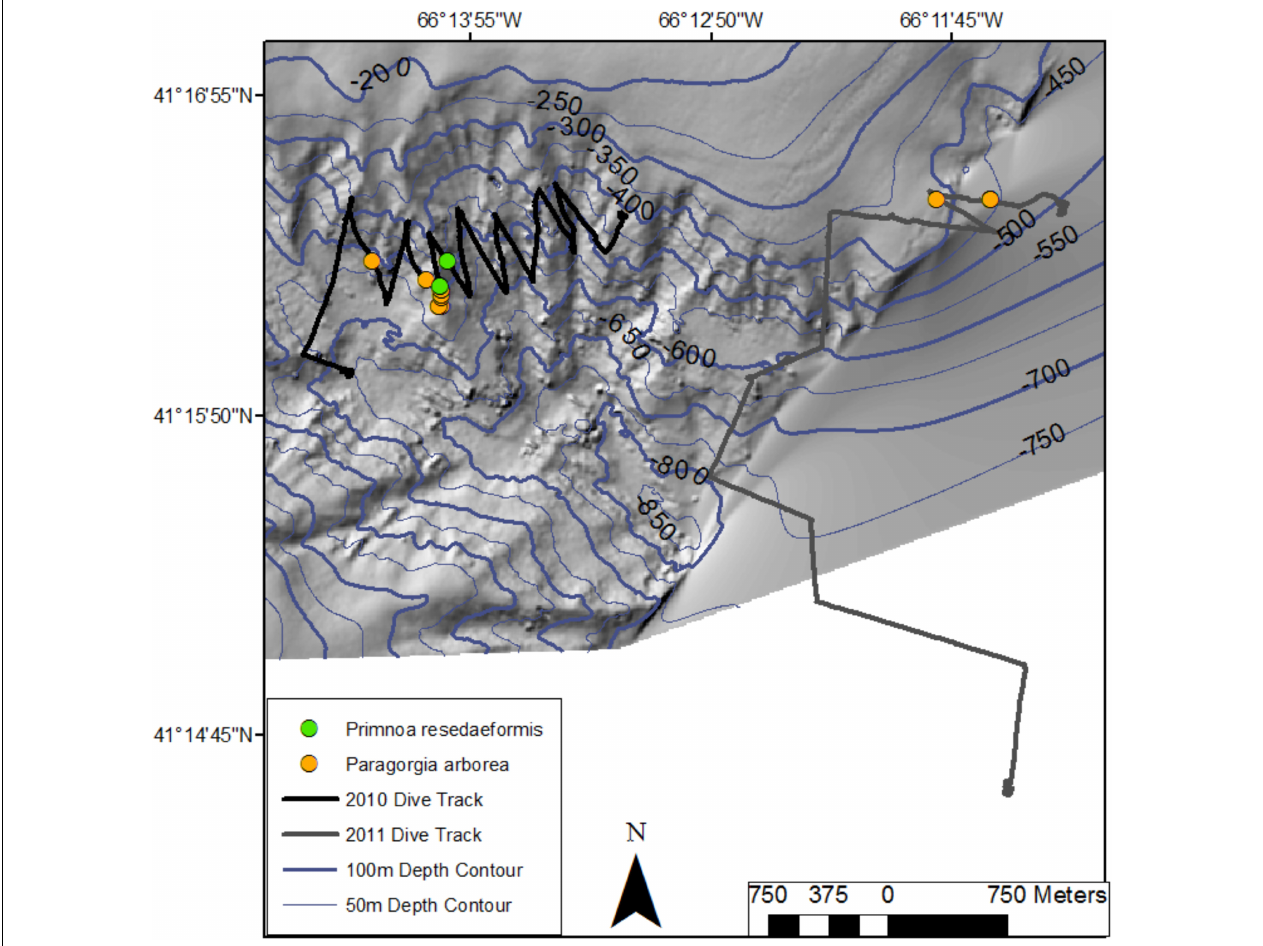
FIGURE 6 | Location of colonies of Paragorgia arborea and Primnoa resedaeformis along two dive tracks in Georges Canyon in 2017 (R2010 and R2011). Bathymetric data provided by the Canadian Hydrographic Service, Fisheries and Oceans - Canada.